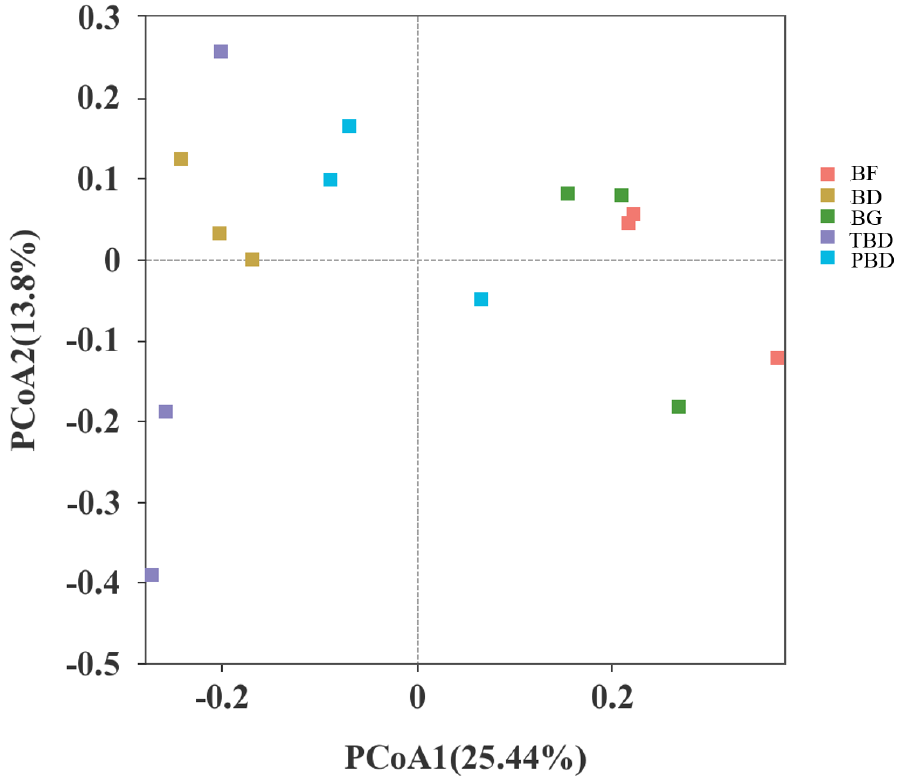
Figure 3. Principal coordinate analysis (PCoA) of soil fungal communities under different treatments based on the Bray − Curtis distance. BD, biochar − organic fertilizer; TBD, Trifolium repens L.